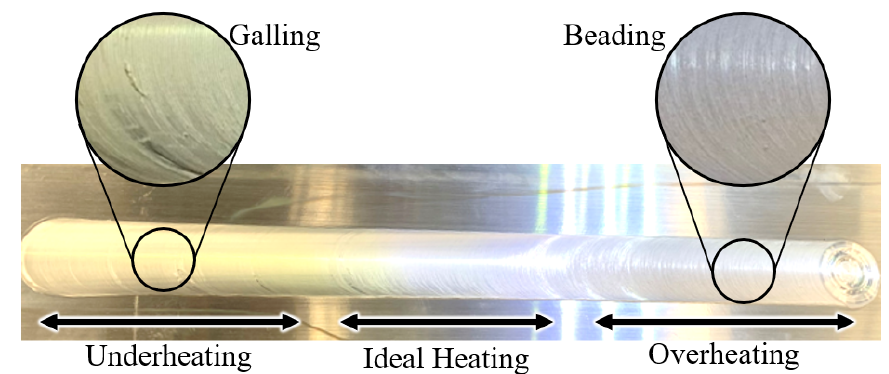
Figure 2. Effects of underheating, ideal heating, and